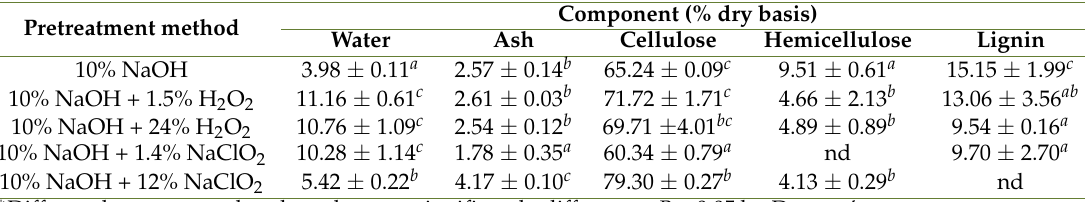
Table 2. Chemical components of OPEFB after pretreatment process.